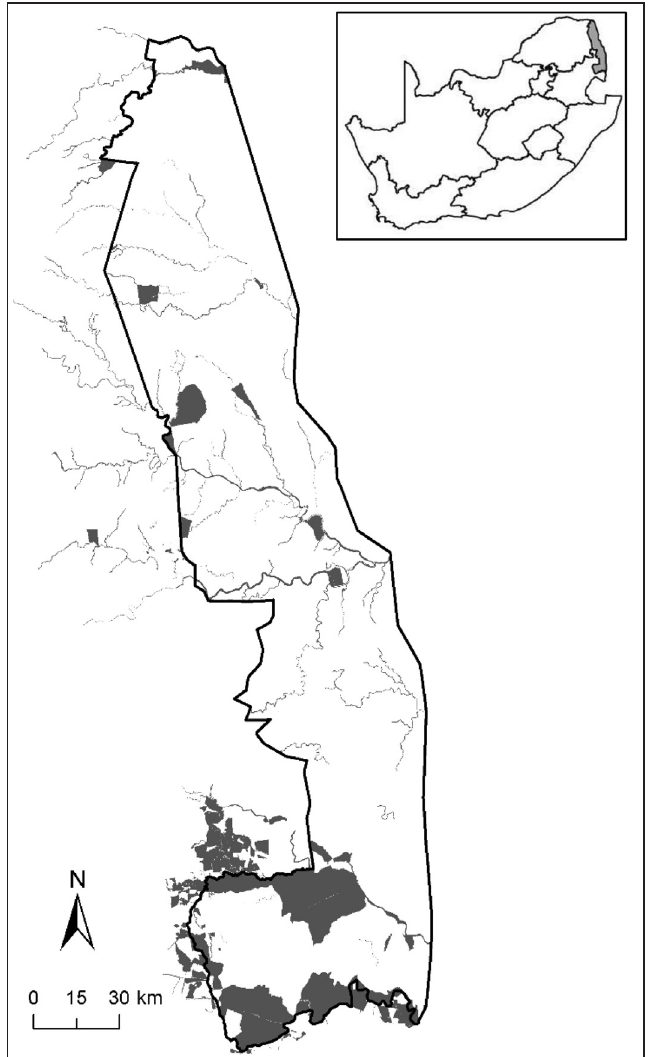
Figure 1. Areas in which alien plant control operations were carried out inside and outside Kruger Na- tional Park, South Africa (2002-present). This illustrates the extent of preventative clearing intended to reduce the risk of ongoing invasion from outside of the protected area. The black line delineates the park boundary. Inset shows the location of Kruger National Park within South